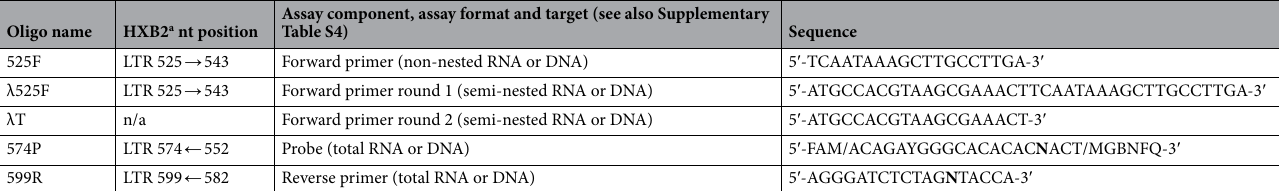
Instrument, and probe–chemistry optimization. Assay optimization of the revised oligonucleotides was performed on a variety of instruments and finalized on a QuantiStudio 3™ thermocycler (ThermoFisher Sci- entific) using a major groove binding (MGB) probe containing a non-fluorescent quencher. The MGB group at the 3 ′ end of the probe increased its melting temperature ( T m ) while the NFQ component of the probe quenched the signal from the 6FAM fluorescent dye before hydrolysis, in a manner that resulted in an even lower back- ground signal than a non-NFQ probe. The finalized protocol as described in the methods resulted in a greatly improved assay with a linear dynamic range of over 7 logs (Figs. 1, 2). PCR reagents and protocols. Generally, the step-up cycling protocol using 10 ng/ml tRNA provided greater sensitivity, linearity and precision when compared to universal cycling conditions (Fig. 2a; Table 2).